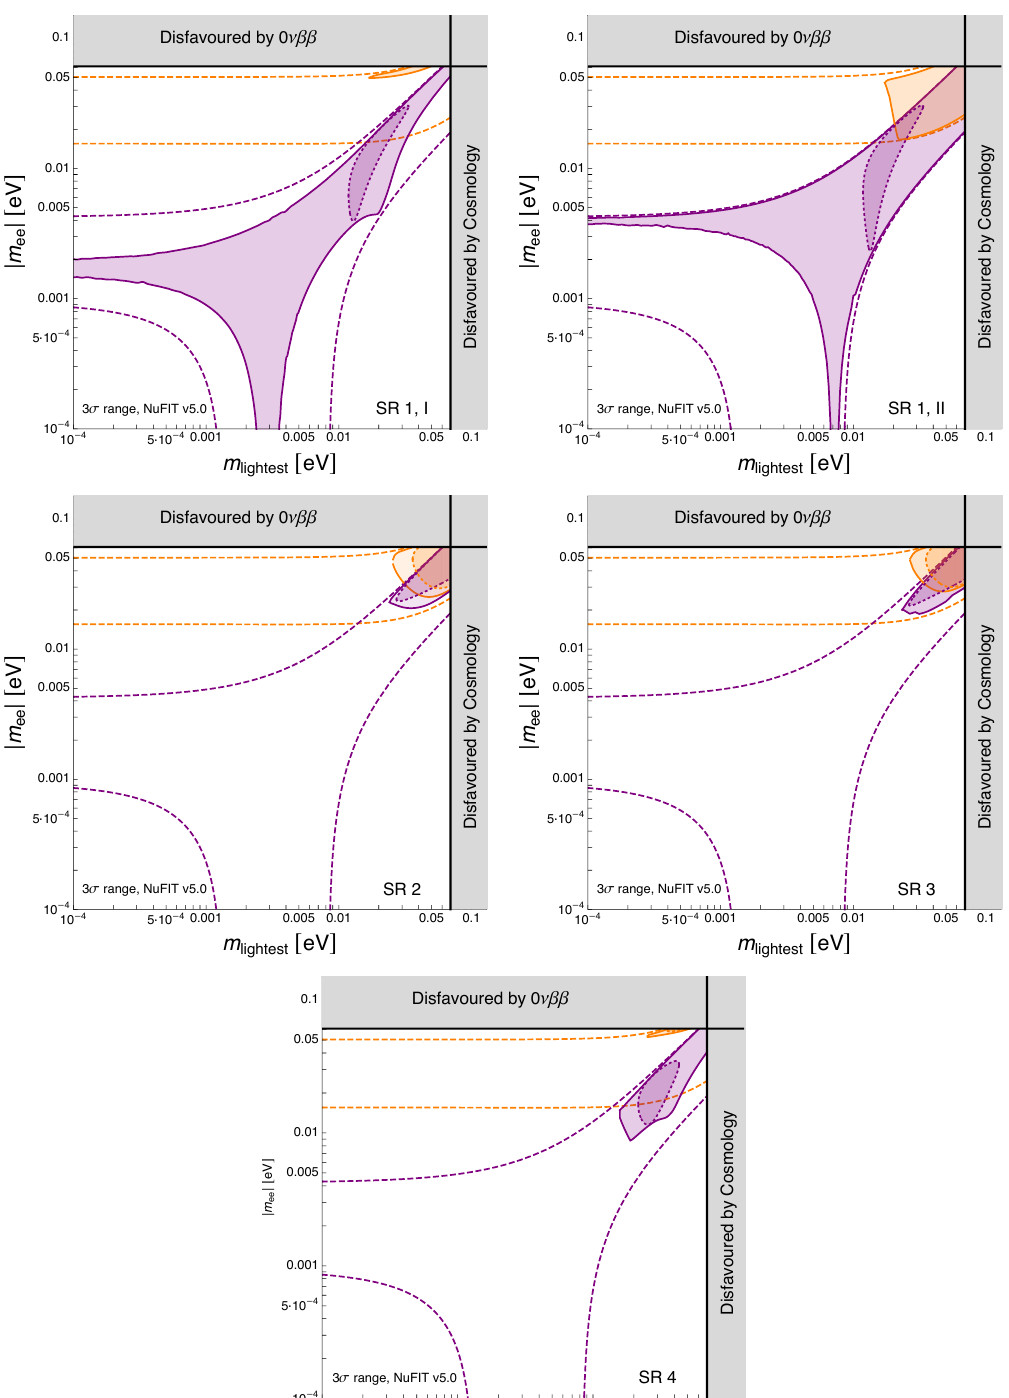
Figure 4 . Allowed ranges for | m ee | for all sum rules. The purple/orange dashed region is the 3 σ allowed region without sum rules for NO/IO. The lightly (dark) shaded purple/orange region is the 3 σ (best fit) allowed region for NO/IO. For more details, see main